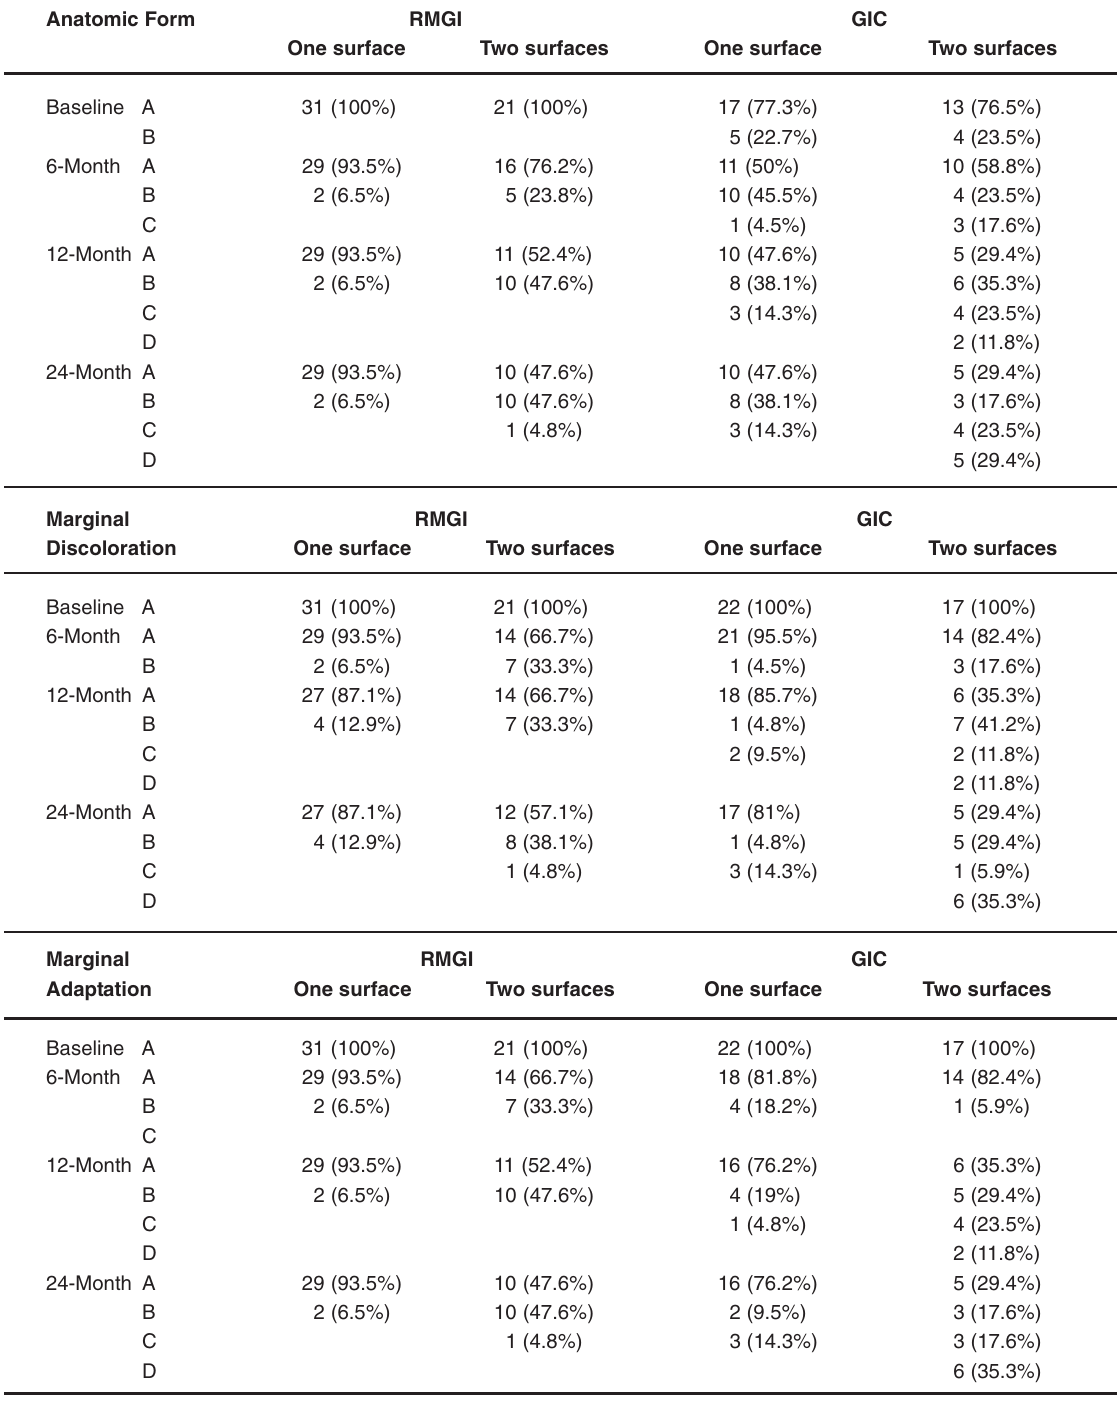
TABLE 2- Number and percent distribution of both RMGI and GIc-ART restorations at baseline, 6, 12 and 24-month-recall according to USPHS